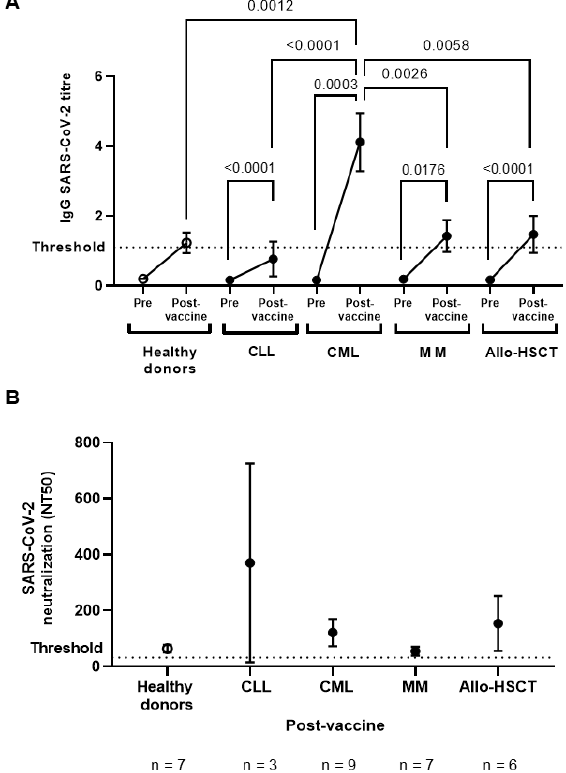
Figure 1. Serological response against SARS-CoV-2 vaccine in plasma from individuals with OHD. ( A ) IgGs titers in plasma from individuals with CLL, CML, MM, or Allo-HSCT chronic lymphocytic leukemia (CLL), chronic myeloid leukemia (CML), multiple myeloma (MM), or allogeneic stem cell transplant (Allo-HSCT) after receiving one-dose of SARS-CoV-2 vaccine, in comparison with healthy donors. ( B ) Neutralizing activity against SARS-CoV-2 of IgGs from individuals with OHD and healthy donors after one-dose vaccination. Each dot in the graph corresponds to mean ± standard error